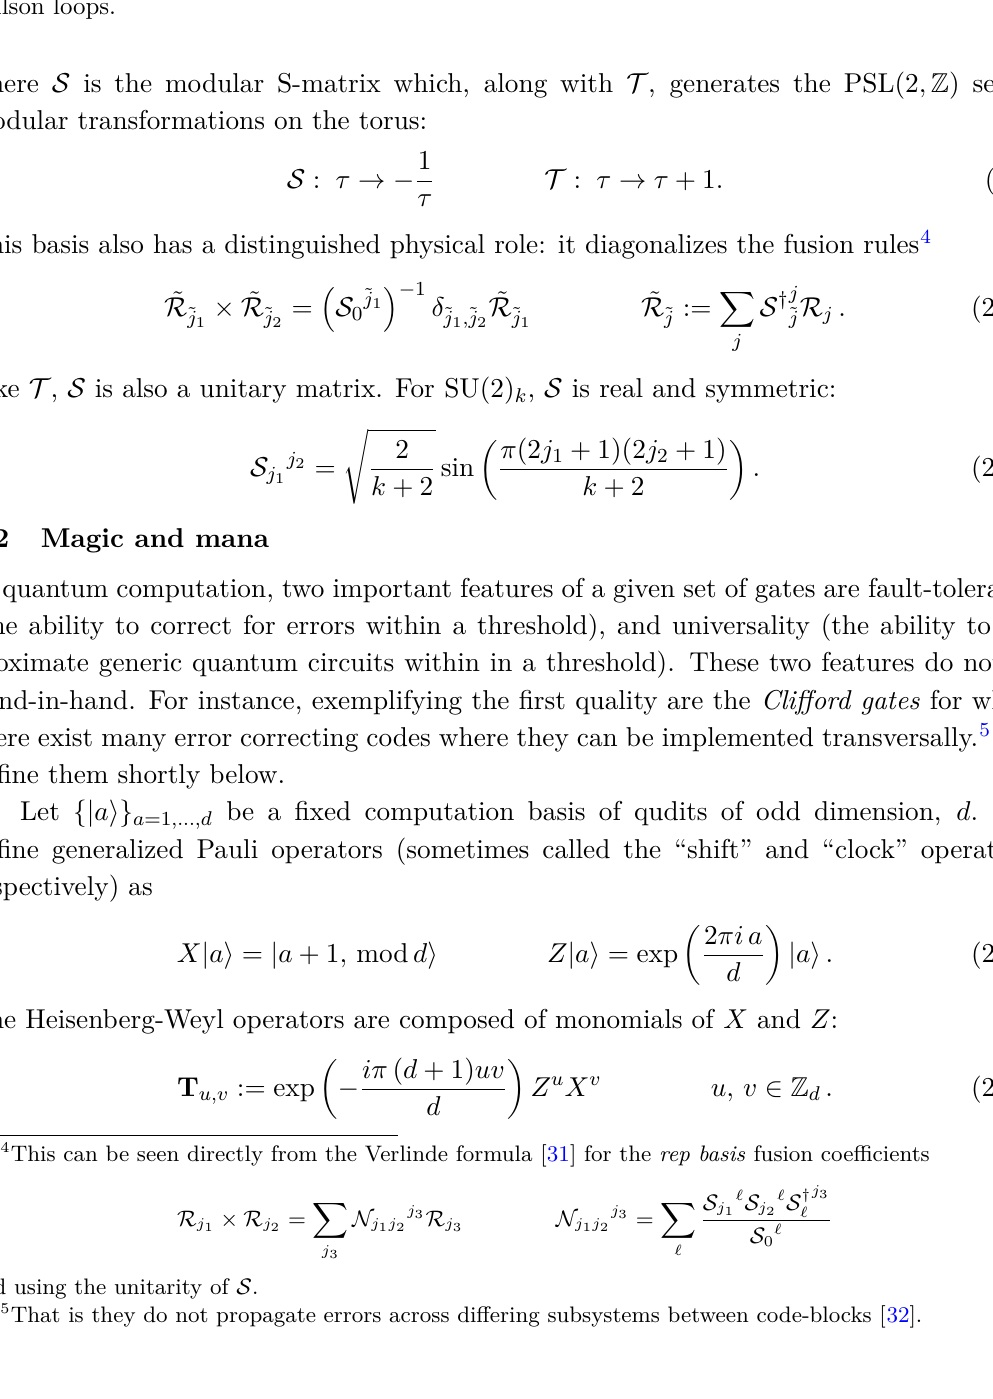
Figure 1 . (Left) From a link L , obtaining the link complement by deleting N ( L ) from S 3 . (Right) The wave-function of the associated state in the rep basis is given by the S 3 expectation values of Wilson